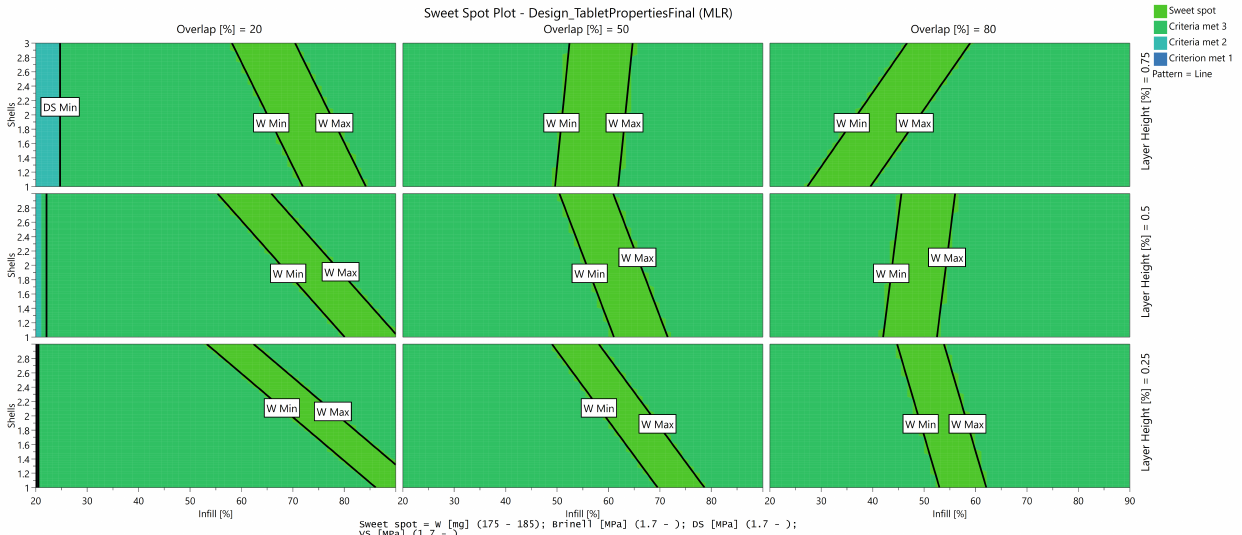
Figure 9. Sweet spot plot presenting the region in the knowledge space where the caplet will meet the user’s specified